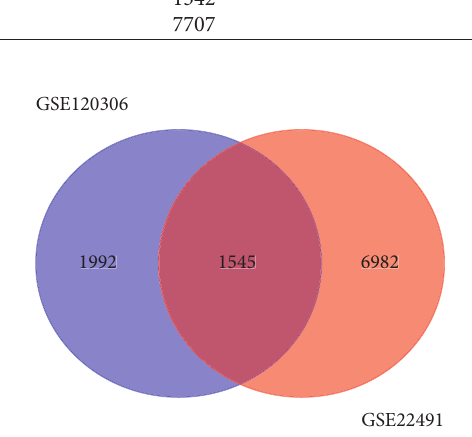
Figure 1: Venn diagrams of DEGs in the experimental group and the verification Table 2: The m6A modification genes in the two groups of DEGs.